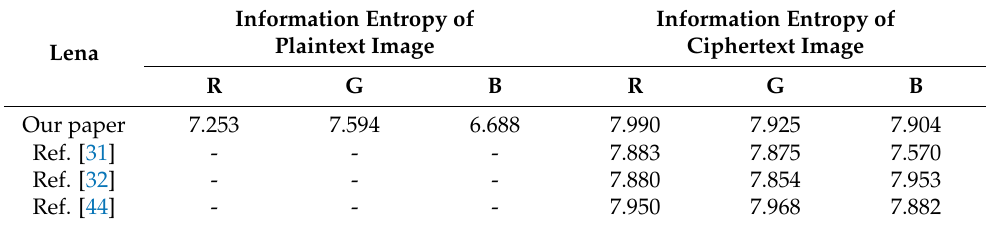
Table 3. Information entropy of clear and ciphertext